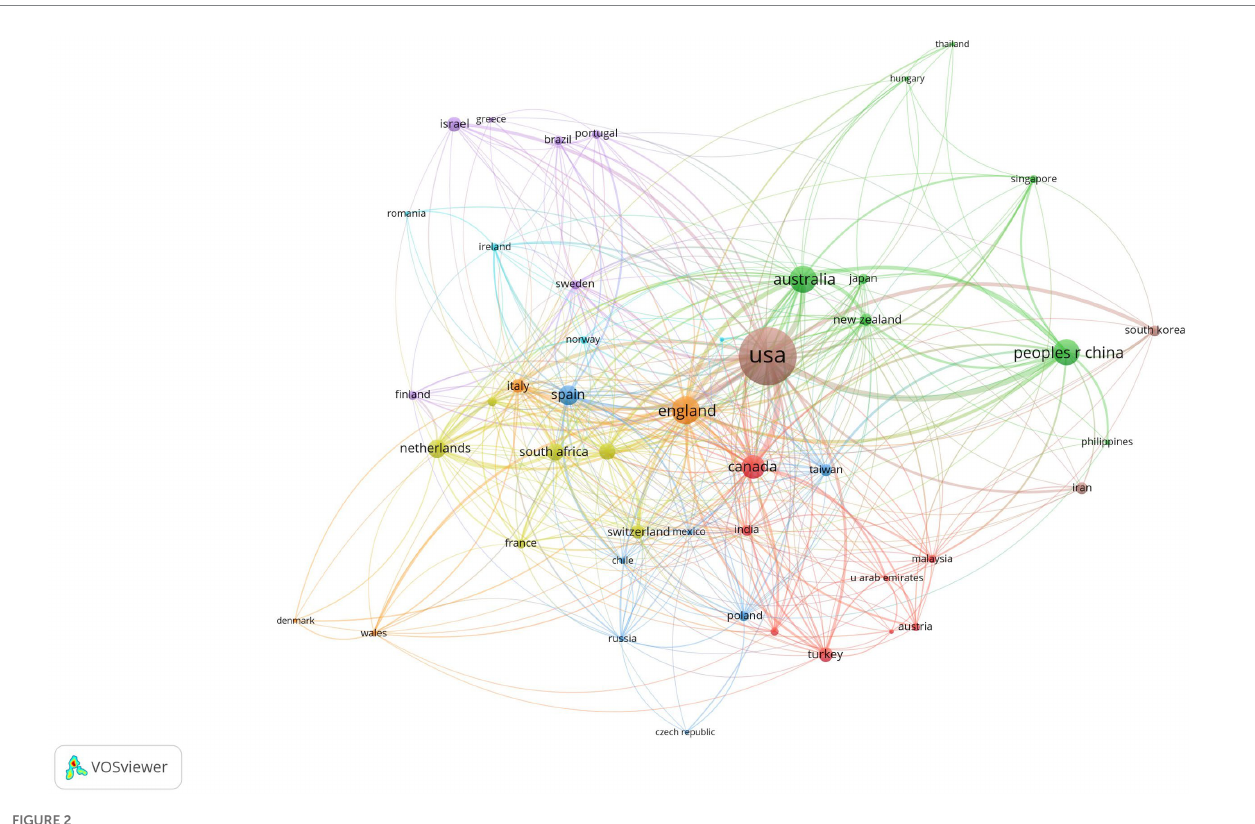
FIGURE 2 Map of countries/regions in positive psychology research.